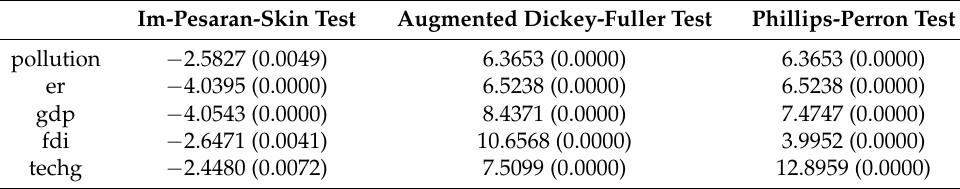
Table 3. Unit root